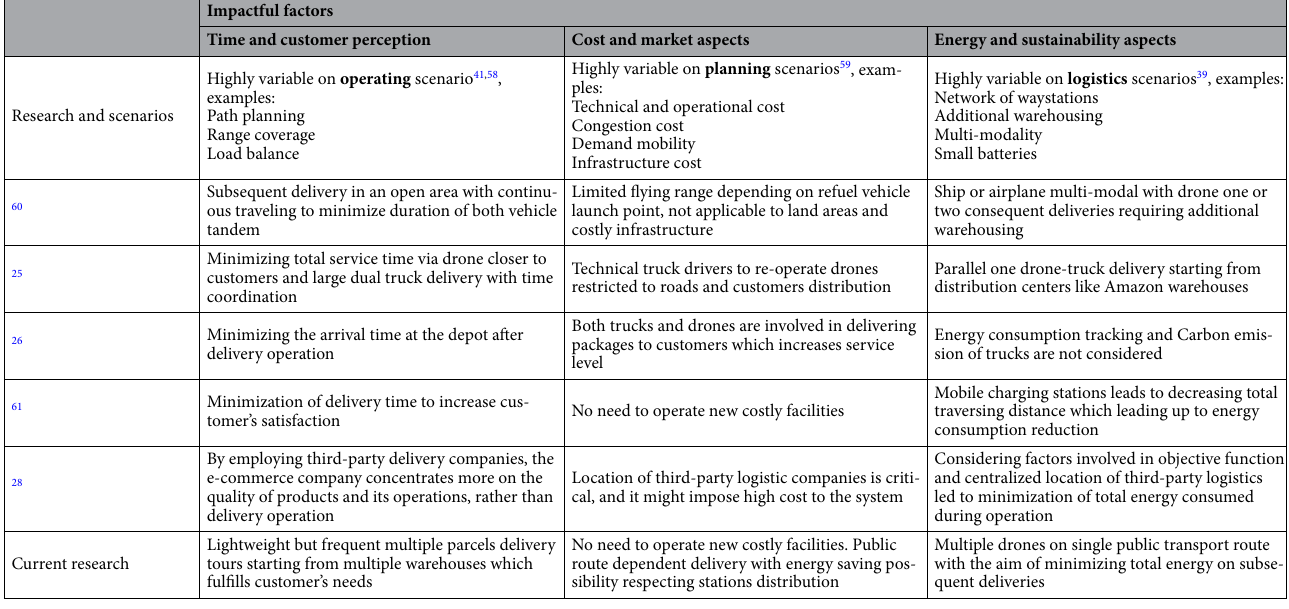
Table 3. Impactful factors for application of Drone technology and the proposed model